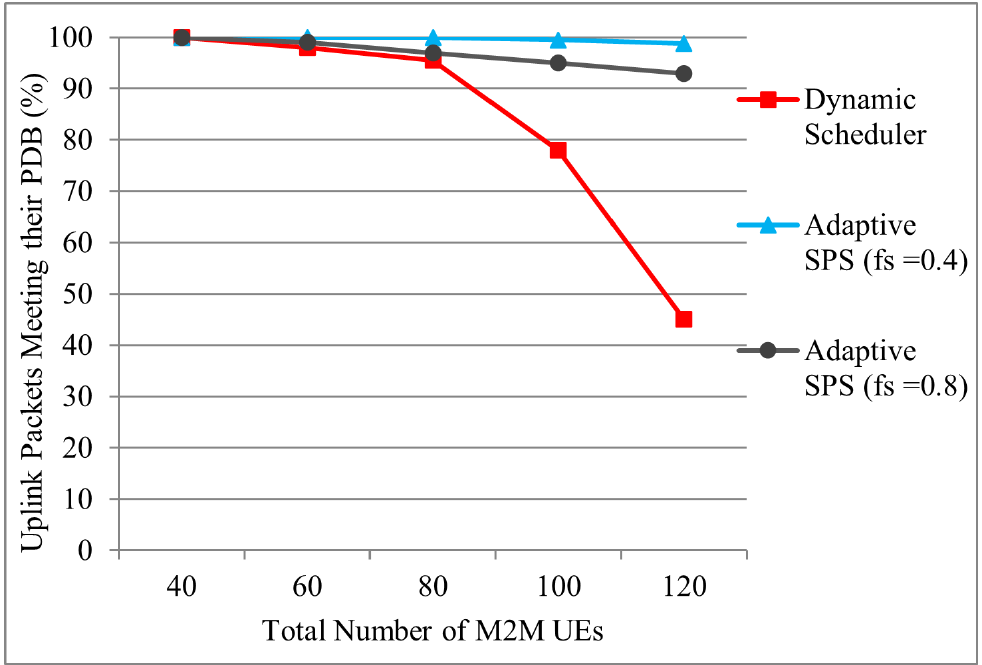
Figure 19. Percentage of packets meeting delay budget with DRX power